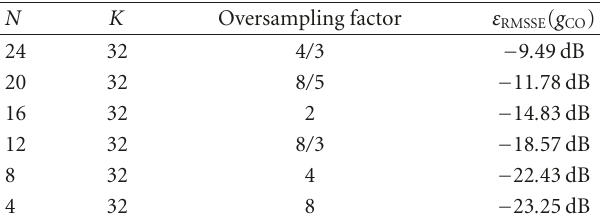
Table 1: Model error for di ff erent oversampling